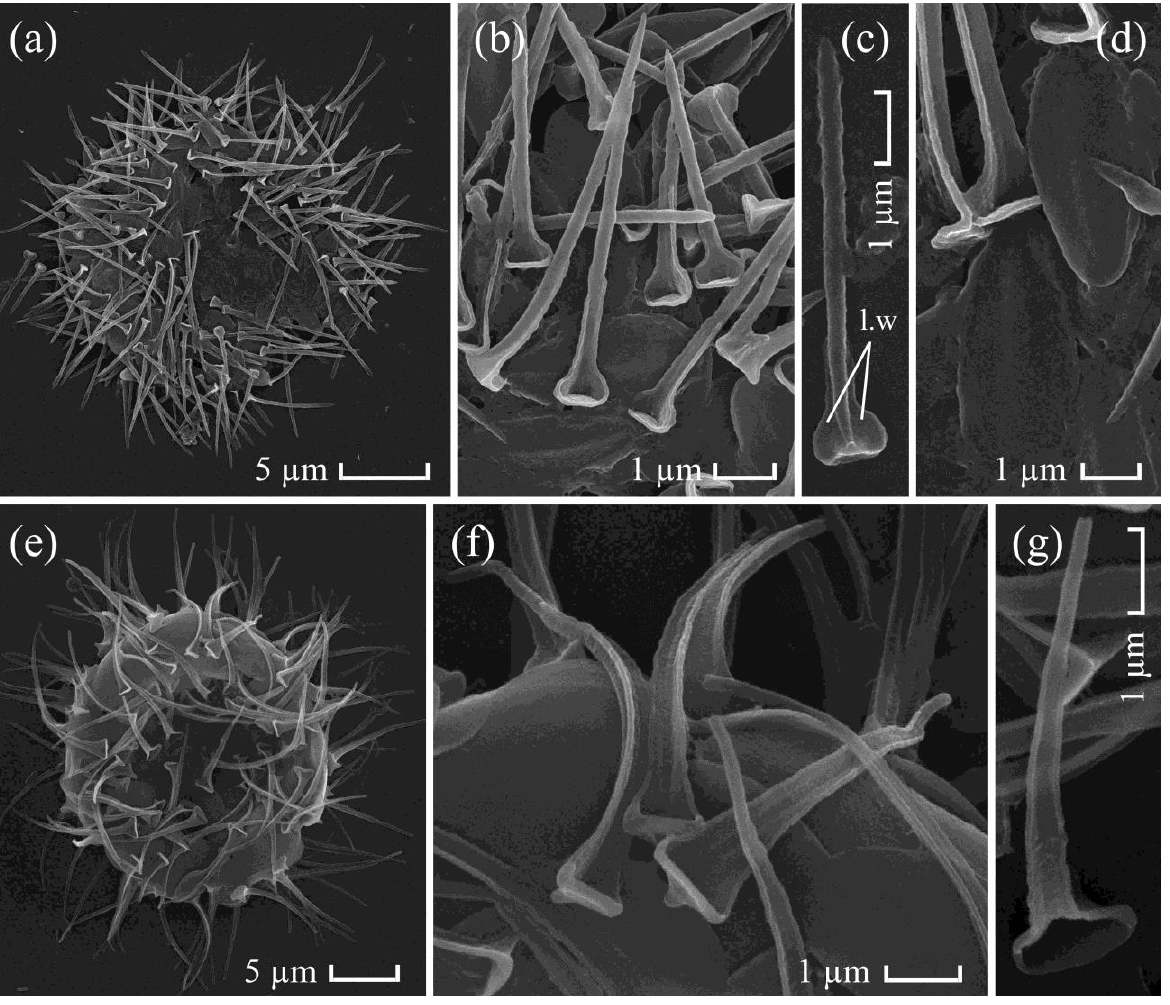
Figure 7. Morphology of observed scales of centrohelid genus Raineriophrys , SEM. (a)–(d) R. erinaceoides : (a) scales of single cell; (b) spine scales; (c) spine scale, dorsal side; (d) plate scales. (e)–(g) R. kilianii : (e) scales of single cell; (f) spine and plate scales; (g) spine scale. Abbreviations: l.w = lateral